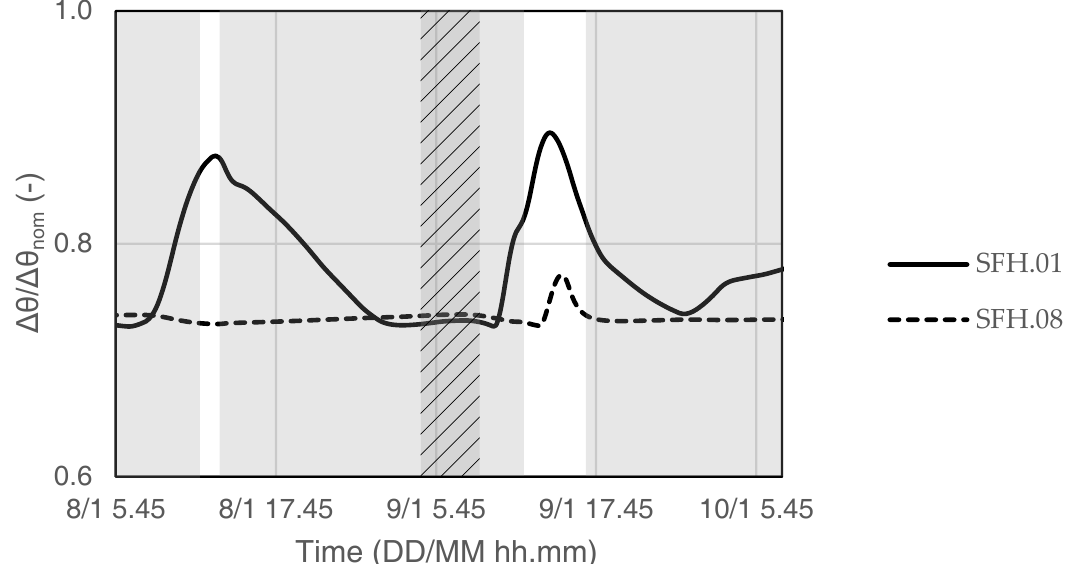
Figure 5. Ratio between actual and design LMTD for an old single family house built before 1900 (solid line) and a new single family house built after 2006 (dashed line), for the same period of the year as in Figure 4. Discomfort periods are indicated by the hatched area (old building) and the gray area (new